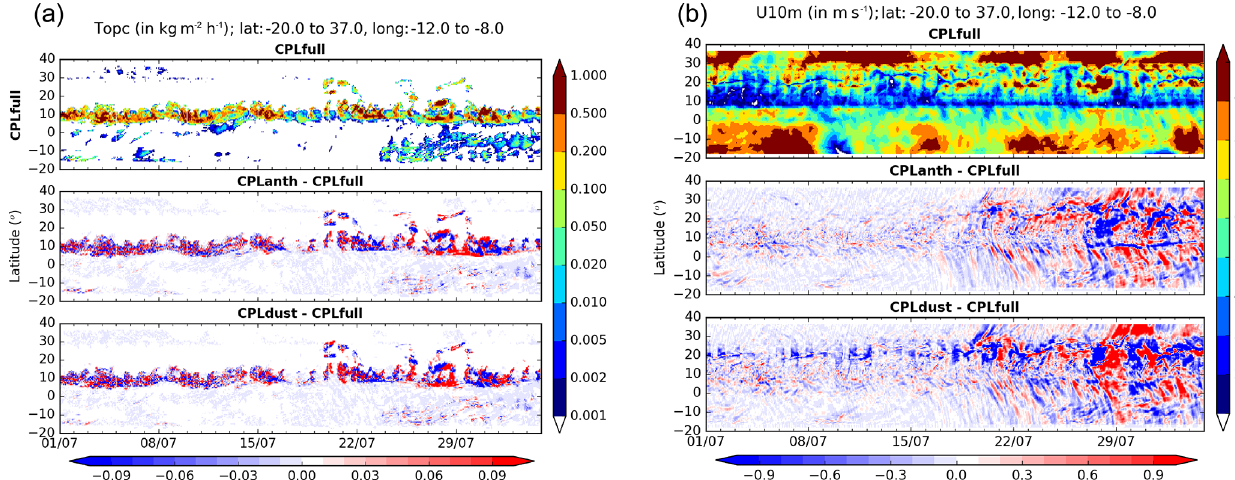
Figure 11. Hovmöller diagrams for total precipitation (a) and 10m wind speed (b) .